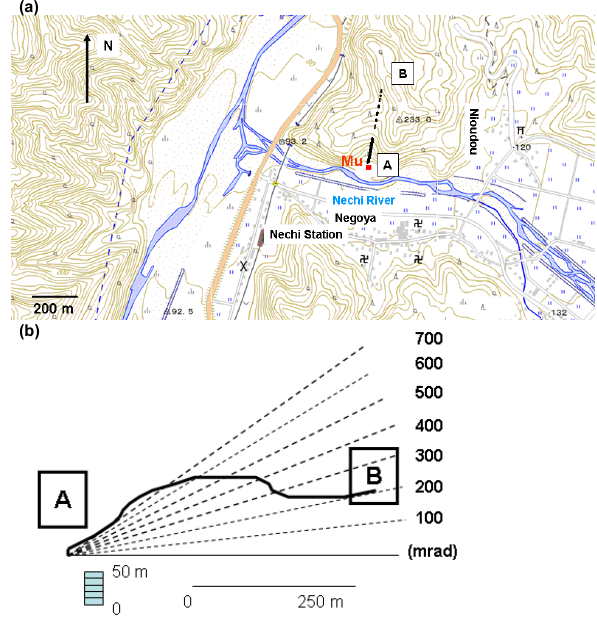
Fig. 1. Geometrical arrangement for the detection system ver- sus Itoigawa–Shizuoka tectonic line (ISTL) fault line taken in the present measurement. A topographic map indicating the detector location Mu (a) and a cross-sectional view of the topography along A–B line ( ϕ =0mrad) (b) are shown. The discovered fault line and the estimated fault line are indicated by a solid and broken line in (a)